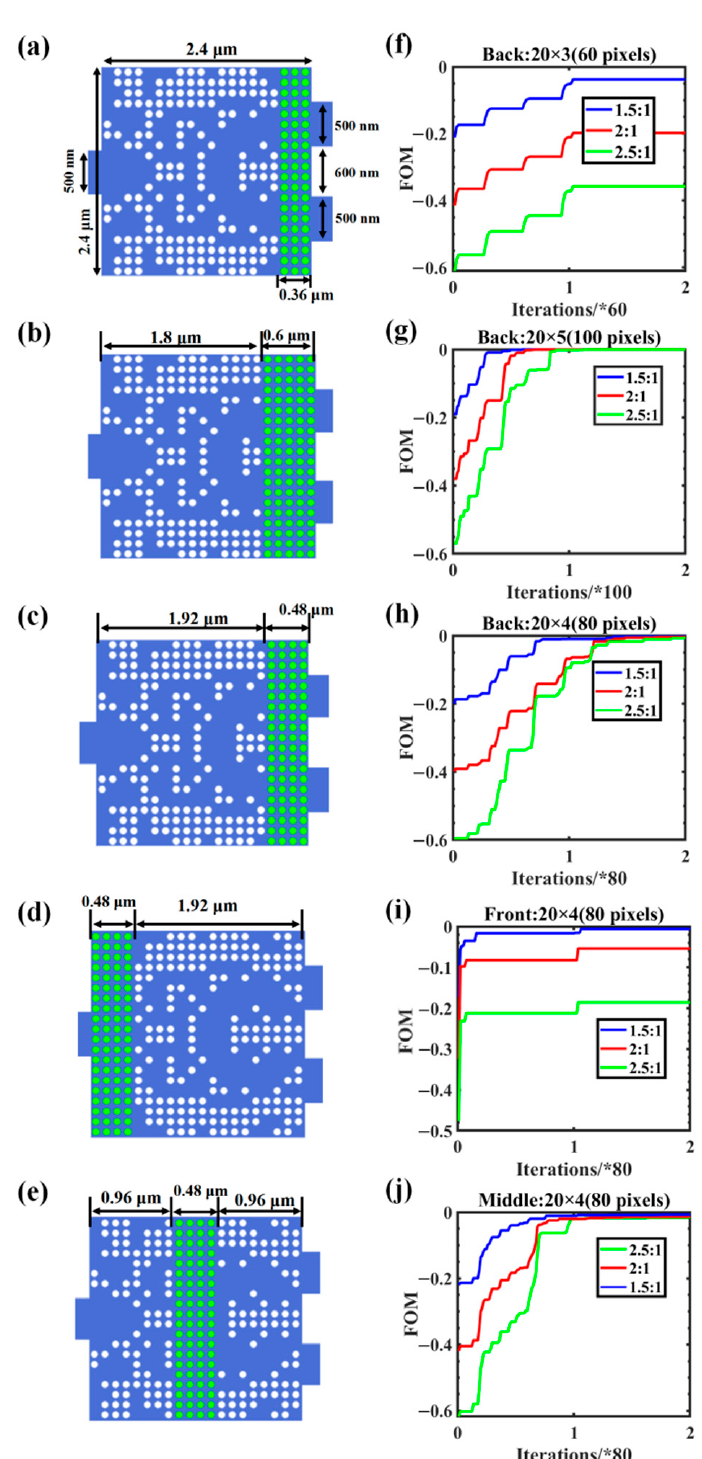
Figure 6. Analysis of the initial structural parameters in the second step of DBS algorithm optimization: ( a – e ) the initial structure of different GSST distributions; ( f – h ) FOM change process corresponding to pixels in the back three columns (60 pixels), the back five columns (100 pixels), and the back four columns (80 pixels) with the number of iterations; ( i , j ) FOM change process corresponding to pixel points in the front and middle four columns with the number of iterations (where the asterisk (*) represents the number of simulations in an iteration).